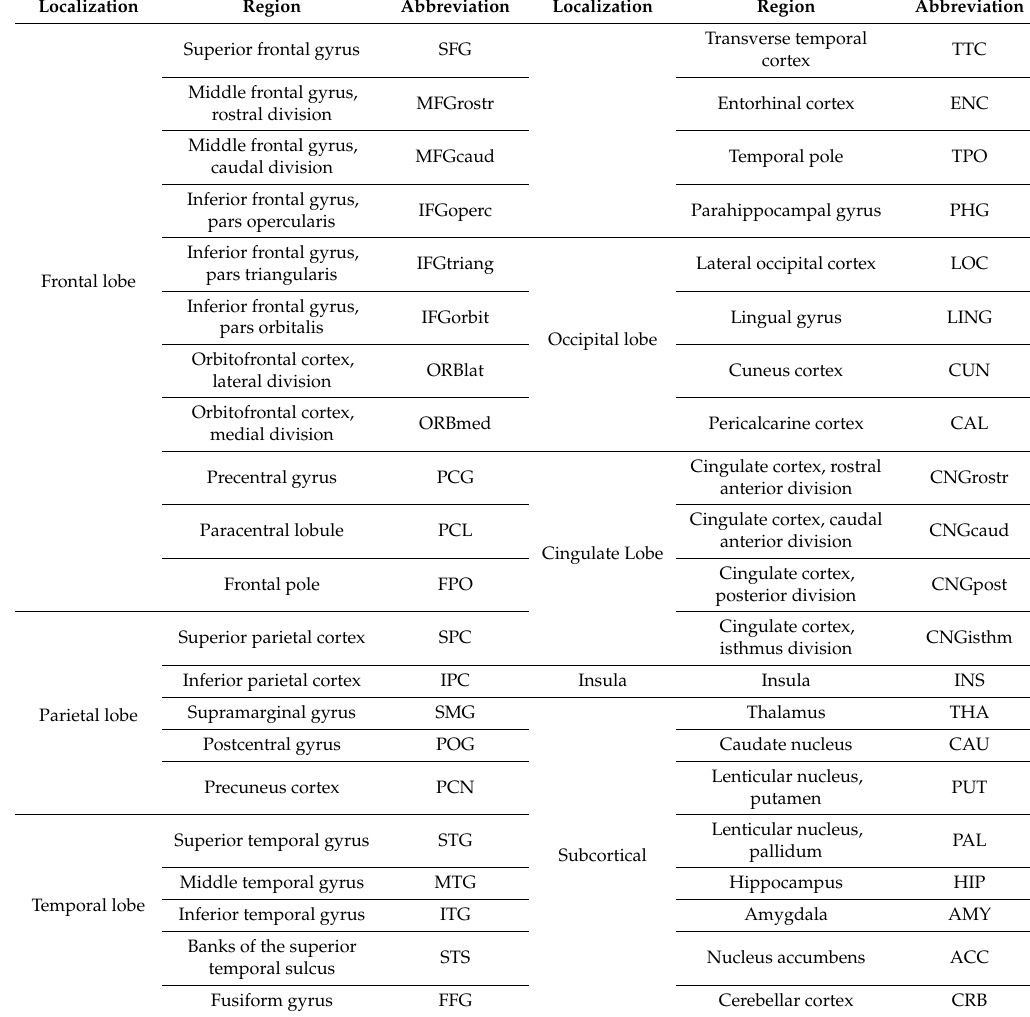
Table 2. Cortical and subcortical regions including in the final parcellation within each hemisphere.